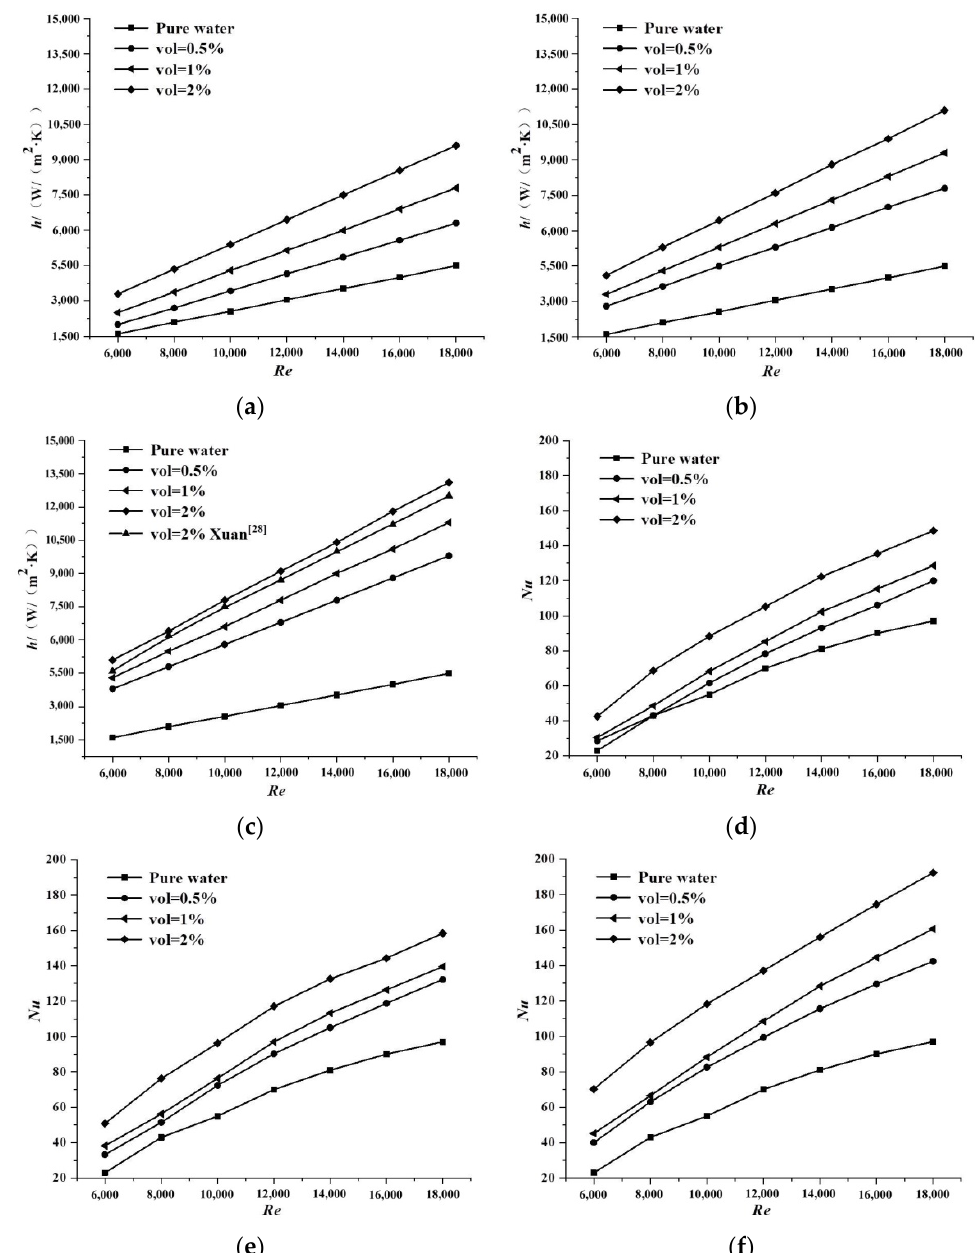
Figure 3. The heat transfer coefficients and Nusselt numbers of Cu-H 2 O nanofluids flow varied with different Reynolds numbers. The diameters of particle were 500 nm ( a , d ), 200 nm ( b , e ), and 100 nm ( c , f ).